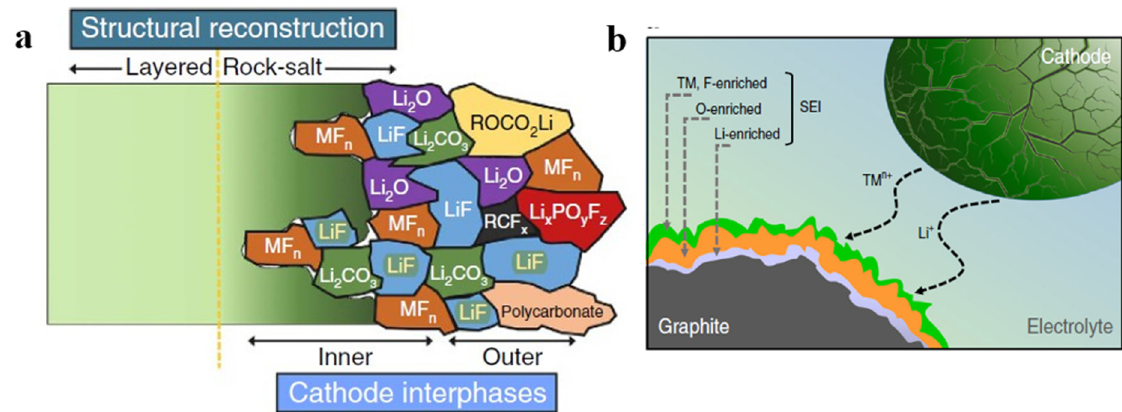
Figure 4. ( a ) Structure of the Ni-rich NMC electrode-electrolyte interface formed after several cycles showing several Li-based compounds and TM-based compounds [46] and ( b) the dissolved TMs enriched the SEI on the anode surface [47].